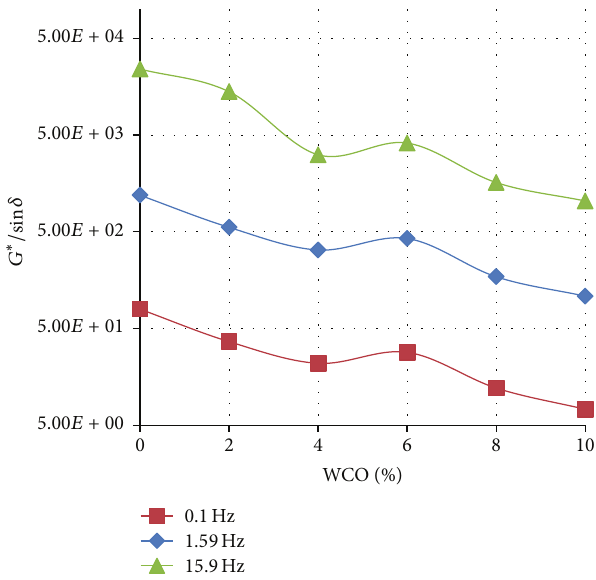
Figure 3: The variation of the fatigue cracking resistance parameter ( 𝐺 ∗ sin 𝛿 ) with increasing concentration of WCO in TLA:TPB (50 :50) at various oscillating frequencies at 60 ∘ C.